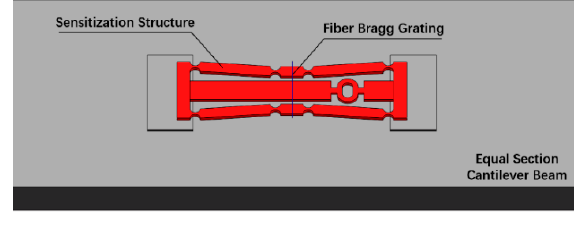
Figure 5. Assembly 3D model. Table 2. Material parameters used in simulation.